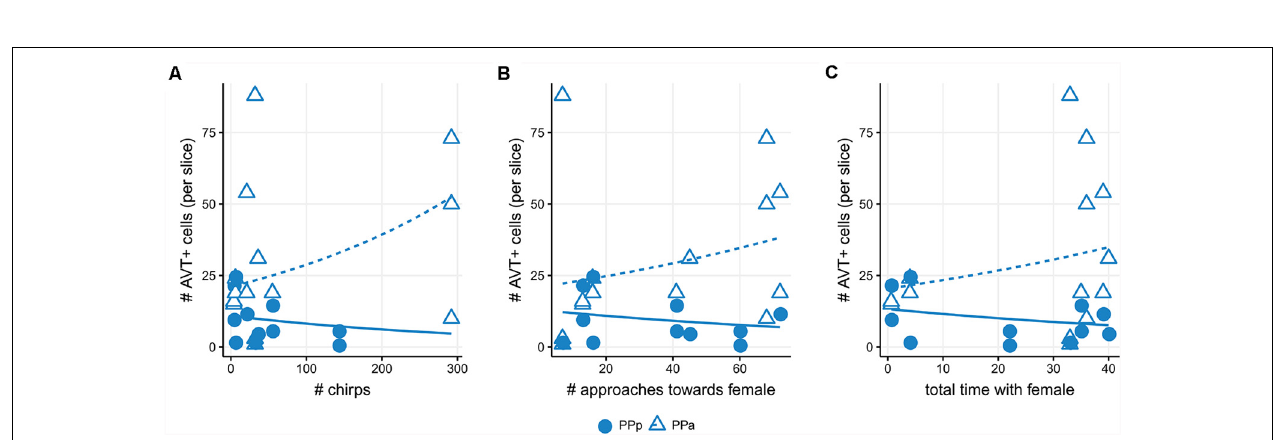
FIGURE 6 | Number of AVT+ cells correlate with behavioral traits in social males. (A) Positive correlation between the number of AVT+ cells in PPa sections and chirp number (triangles; p < 0.001). Negative correlation between the number of AVT+ cells in PPp sections and chirp number (dots; p < 0.001). (B) Positive correlation between the number of AVT+ cells in PPa sections and approaches towards a female (triangles; p < 0.001). Negative correlation trend between the number of AVT+ cells in PPp sections and approaches towards a female (dots; p = 0.08). (C) Positive correlation between the number of AVT+ cells in PPa sections and total time with the female (triangles; p = 0.001). Negative correlation between the number of AVT+ cells in sections and total time with the female (dots; p =